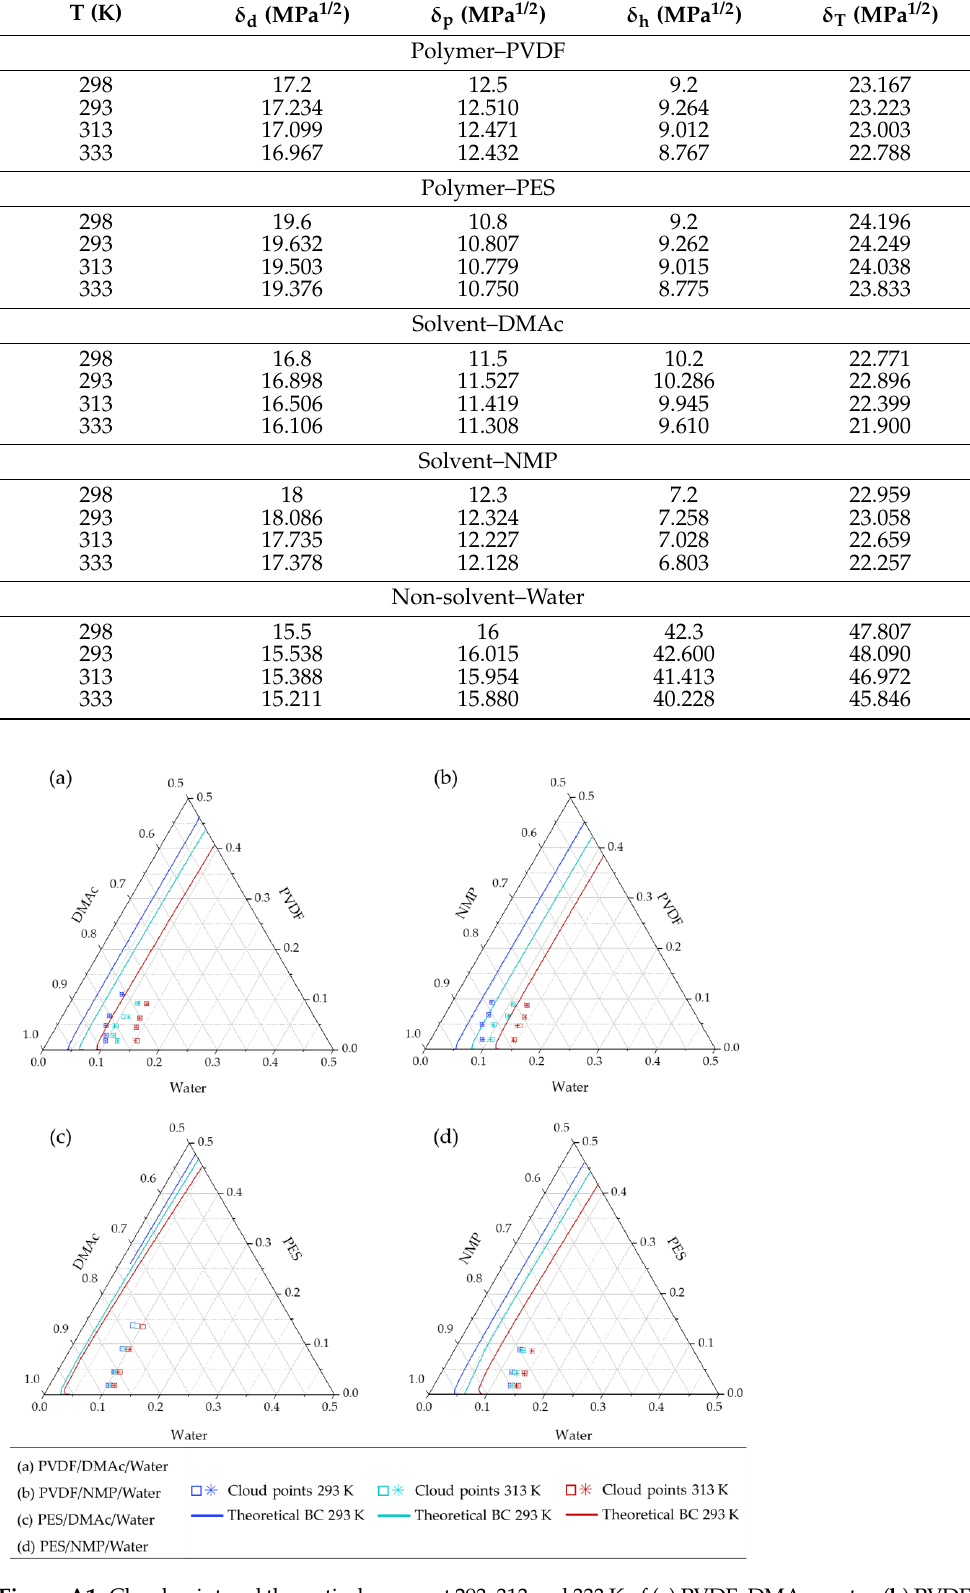
Table A4. Solubility parameters calculated at different temperatures from Hansen solubility parame- ters at 298 K.